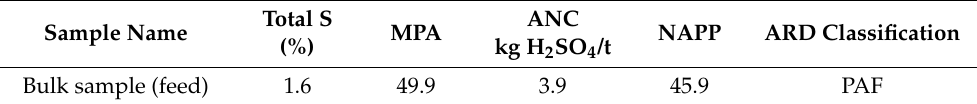
Table 4. Acid base accounting test (ABA) results showing the total sulfur (S), maximum potential acidity (MPA), acid neutralizing capacity (ANC), and net acid producing potential (NAPP) for coal discards. PAF = potential acid